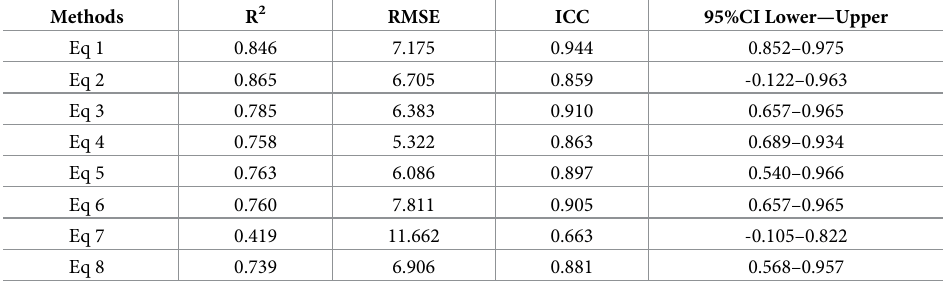
Table 4. Analysis of concordance between the percentage of fat-free mass (%FFM) in boys with Duchenne muscu- lar dystrophy, estimated by predictive equations by bioelectrical impedance (Eq 1 –Eq 8) and determined by dual- energy X-ray absorptiometry (DXA).